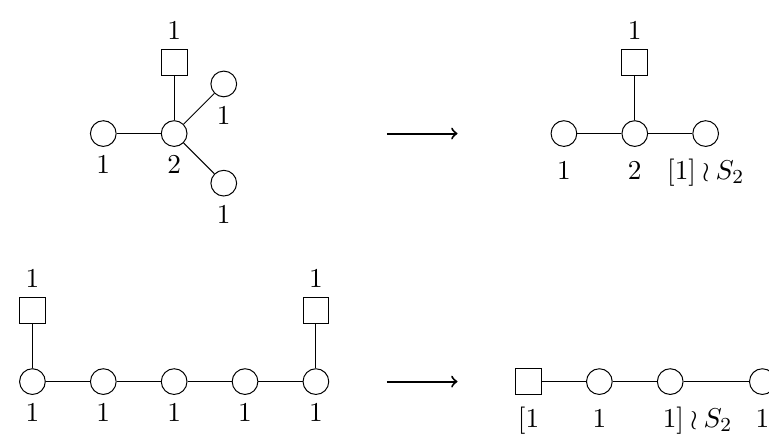
Figure 3 . Quivers on the left wreathe into quivers on the